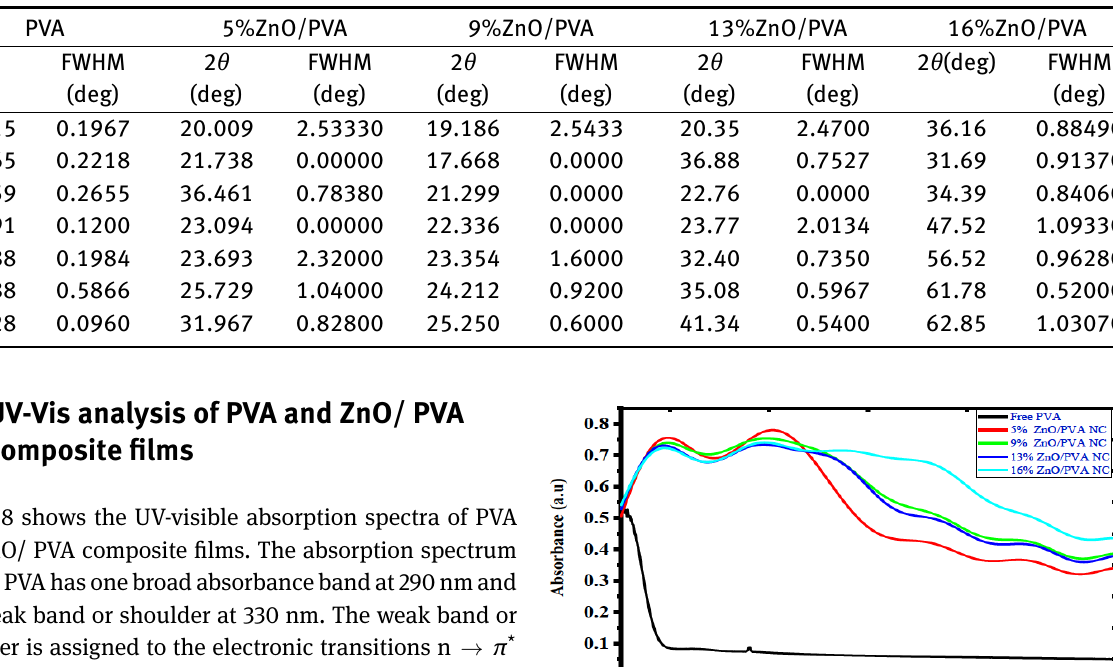
Table 3: XRD data for PVA and ZnO/PVA NCs